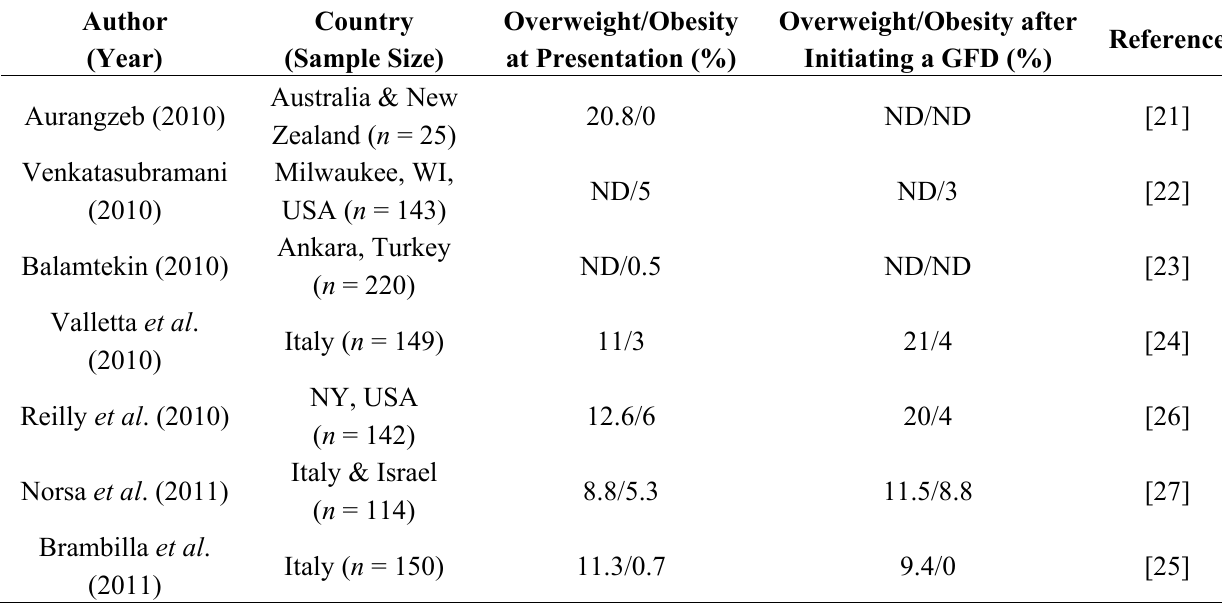
Table 1. Prevalence of overweight/obesity in